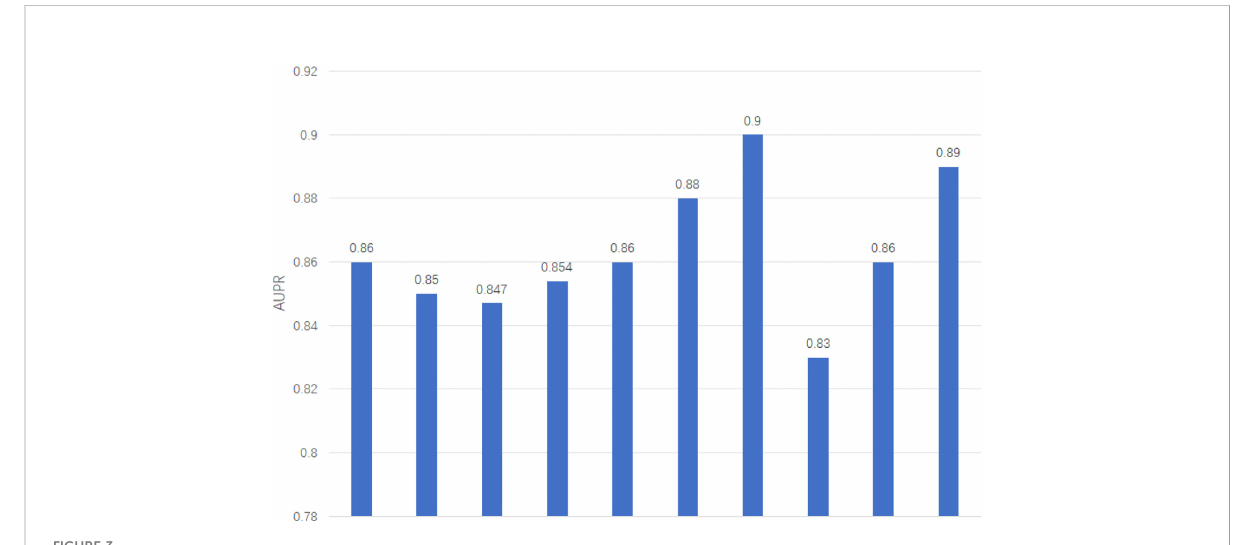
FIGURE 2 AUC curves of GCNLMF in 10-cross validation.